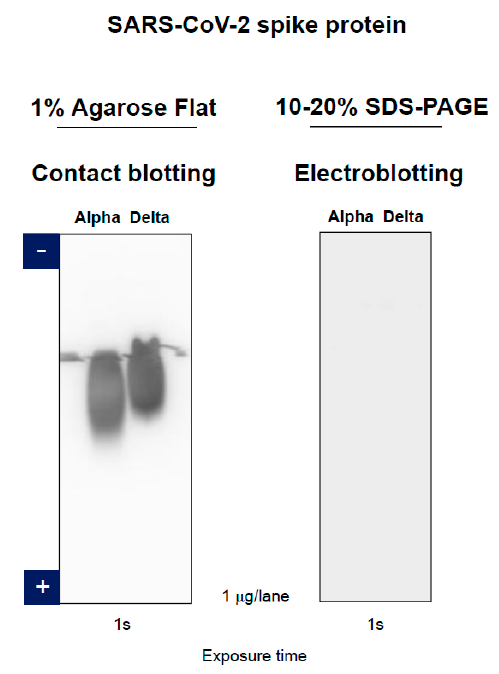
Figure 15. Comparison of contact blotting of agarose gel and electroblotting of SDS polyacrylamide gel using SARS-CoV-2 spike protein. Alpha and Delta variants of SARS-CoV-2 spike proteins were detected by specific monoclonal antibody. Left panel, contact blotting of agarose gel. Right panel, electroblotting of SDS polyacrylamide gel (semi-dry condition).